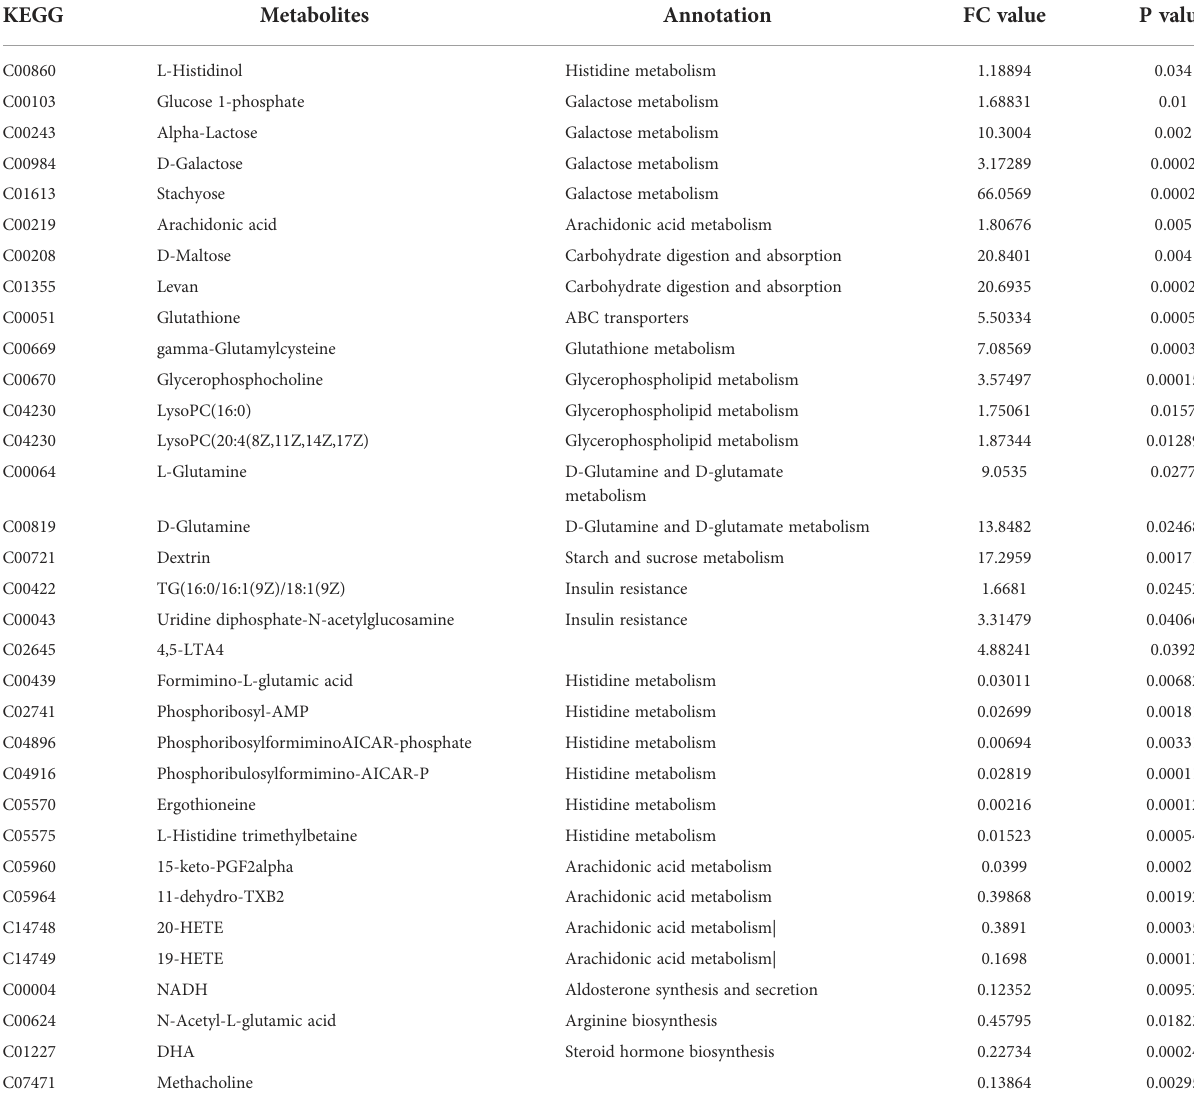
TABLE 1 The DEPs between HFD/NCD (FC value>1, upregulated proteins, FC value<1, downregulated proteins).